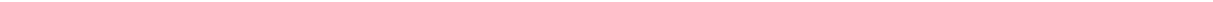
Fig. 4 Y1 receptor signaling regulates β -cell function via a cAMP-CREB-dependent pathway. a Pancreas weight of BIBO3304 vs. placebo-treated WT mice ( n = 3). b Total islet number of BIBO3304 compared to placebo-treated WT mice ( n = 3). c Representative photomicrographs of islets stained for insulin from BIBO3304 and placebo-treated WT mice ( n = 3). d Total islet area of BIBO3304 compared to placebo-treated WT mice ( n = 3). e Quanti fi cation of Ki67-positive β -cells in islets from BIBO3304 or placebo-treated WT mice. f cAMP production of WT islets in response to 2 and 20 mM glucose co-stimulation with GLP-1 receptor agonist, Exenatide (100 nM), in the presence or absence of PYY (50 nM), or BIBO3304 (1 μ M) ( n = 5). g cAMP production of Y1 − / − islets in response to 2 and 20 mM glucose co-stimulation with GLP-1 receptor agonist, Exenatide (100 nM), in the presence or absence of PYY (50 nM), or BIBO3304 (1 μ M) ( n = 5). h , i Pancreatic islets from WT mice treated with placebo or BIBO3304 and Y1 − / − mice were isolated